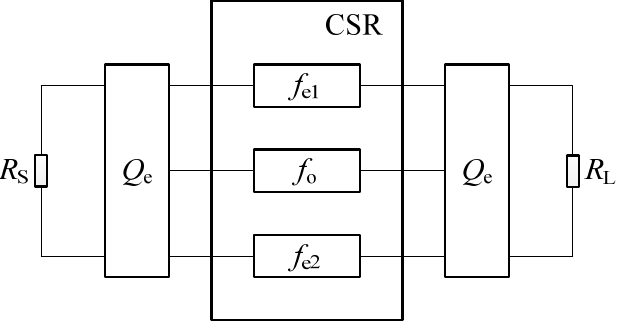
Figure 4. Topology architecture of the proposed filter.